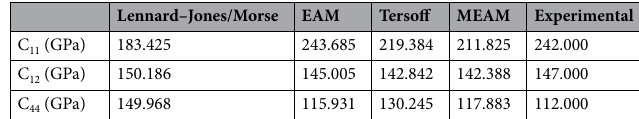
Table 4. Calculation results of ferrite elastic constants.